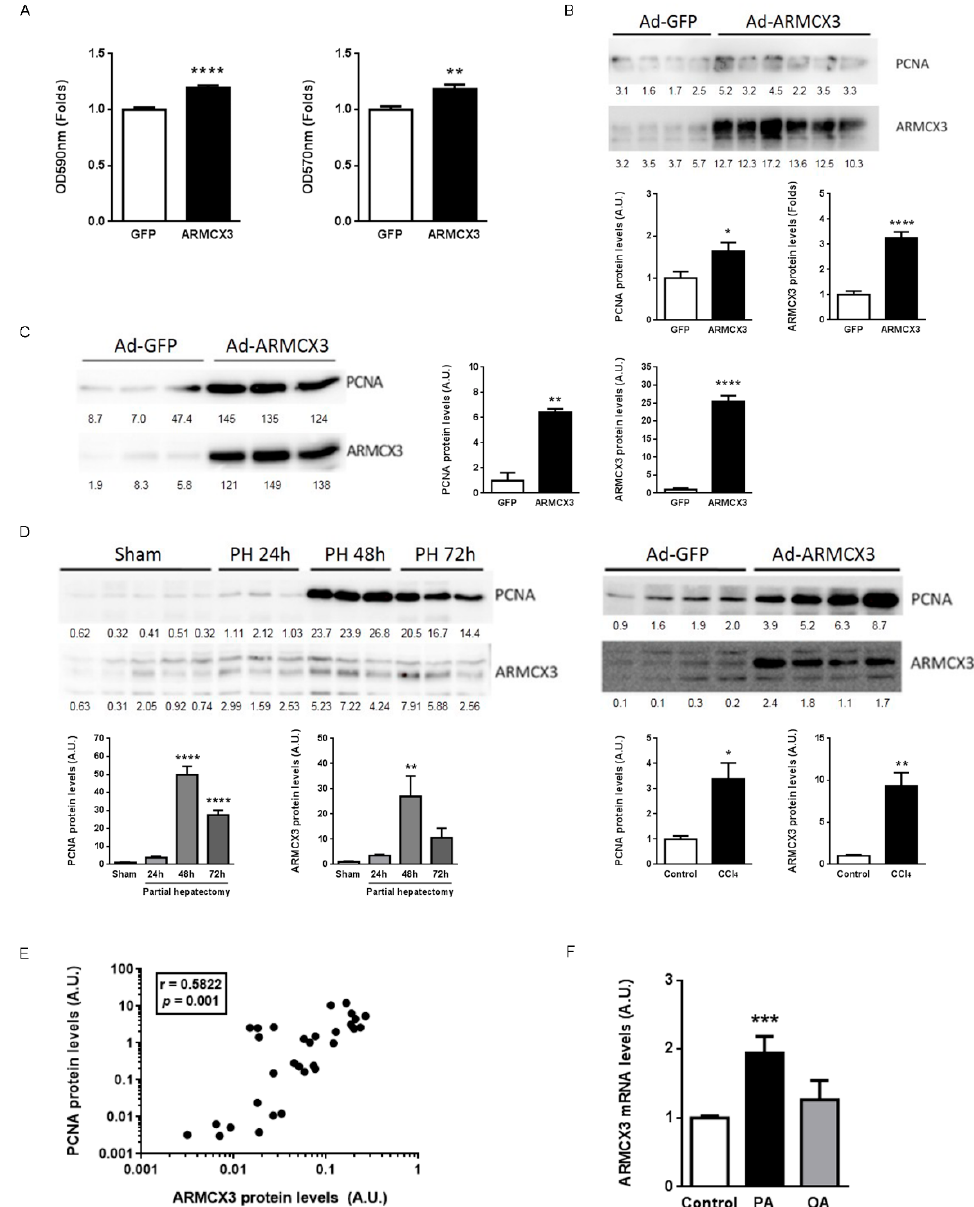
Figure 6. ARMCX3 expression correlates with the proliferative capacity in hepatocytes. ( A ) MTT and colony-forming assays in SNU423 cells overexpressing ARMCX3 at 48 h post-transduction. ( B ) PCNA protein levels in the cells described in ( A ), presented as representative immunoblots (top) and quantification (bottom) of PCNA and ARMCX3 levels. ( C ) PCNA protein levels in primary hepatocytes overexpressing ARMCX3 at 48 h post-transduction, presented as representative immunoblots (left) and quantification (right) of PCNA and ARMCX3 levels. ( D ) PCNA and ARMCX3 protein levels in livers of mice subjected to partial hepatectomy at 24 h, 48 h or 72 h post-surgery, and in livers of mice treated with CCl 4 for 48 h; representative immunoblots (top) and quantifications (bottom) are presented. ( E ) Pearson’s correlation between ARMCX3 and PCNA protein levels in hepatocytes ( n = 30). ( F ) ARMCX3 mRNA levels in HepG2 cells treated with palmitic acid (0.3 mM) or oleic acid (0.6 mM) for 24 h. Ponceau staining, which was used as a loading control in the immunoblots, is shown in Figure S5. T ‐ student or Mann ‐ Whitney test with Dunnett post hoc corrections were used. * p ≤ 0.05, ** p ≤ 0.01, *** p ≤ 0.001 and **** p ≤ 0.0001.